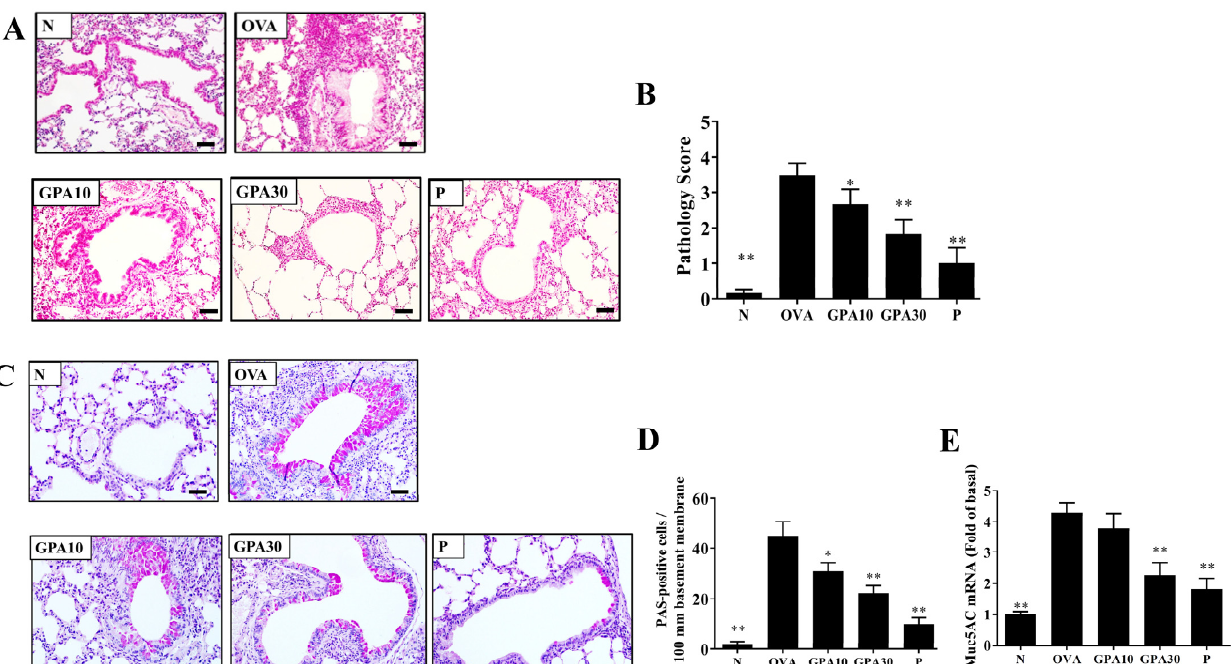
Figure 1. Effect of gypenoside A (GPA) on lung function. ( A ) Gypenoside A reduced eosinophil infiltration (HE stain, 200× magnification) (scale bar = 100 µm). ( B ) Pathological scores in lung tissue. ( C ) PAS-stained lung sections show goblet cell hyperplasia (200× magnification) (scale bar = 100 µm). ( D ) The number of PAS-positive cells per 100 µm of basement membrane. ( E ) Muc5AC expression levels in lung tissue. Three independent experiments were analyzed, and all data are presented as the mean ± SEM (n = 4–6 per group). * p < 0.05 and ** p < 0.01 compared with the OVA control group. Normal saline control group were named as N; Ovalbumin (OVA)-induced asthma mice were named as OVA. The 10 mg/kg and 30 mg/kg gypenoside A were named as GPA10 and GPA30, respectively. The 5 mg/kg prednisolone was named as P.